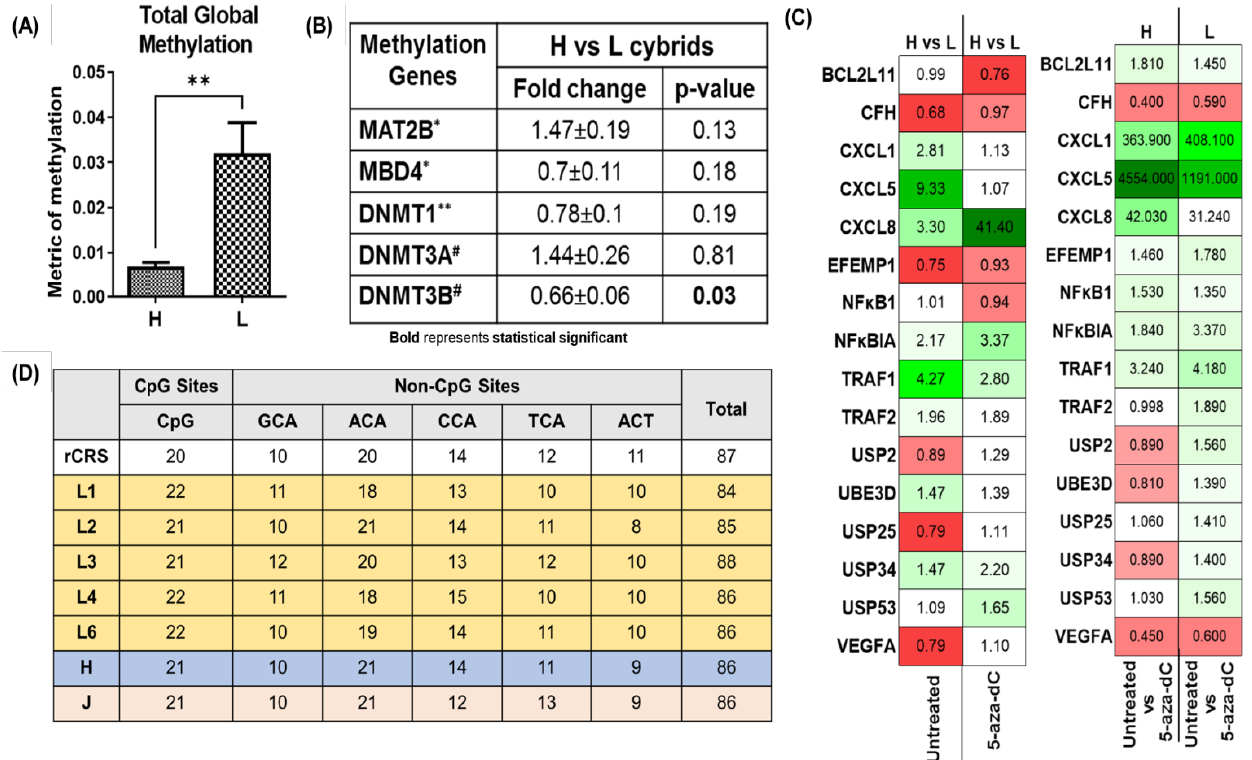
Figure 3. Evaluating the status of methylation in cybrids including mitochondrial haplogroups of European (H) and African (L) ancestry . ( A ) African-L cybrids showed increased levels of total global methylation. H (n = 5) and L (n = 5) cybrids were grown under identical conditions and DNA was extracted. The methylation fraction of DNA was detected using capture and detection antibodies and measured in a microplate spectrophotometer using an ELISA-like reaction (absorbance 450 nm). The OD intensity measured using an absorbance plate reader was proportional to the amount of methylated DNA (5-mC%). The L cybrids had a higher 5-mC% mean value compared to the H cybrids ( p = 0.005). To produce biological duplicates, samples were run in duplicate, and the experiment was repeated twice. ( B ) Expression levels of methylation genes in H cybrids versus L cybrids. Fold-change values greater than 1 indicate upregulation of the gene and those less than 1 indicate down-regulation of the gene compared to H cybrids. H cybrids are assigned a value of 1. * n = 5 different H cybrids and n = 5 different L cybrids, with three values for each sample, ** n = 5 different H cybrids and n = 5 different L cybrids, with three values for each sample, # n = 5 different H cybrids and n = 5 different L cybrids, with three values for each sample. ( C ) Heatmap representation of the differential expression of BCL2L11 , CFH , CXCL1 , CXCL5 , CXCL8 , EFEMP1 , NF κ B1 , NF κ BIA , TRAF1 , TRAF2 , USP2 , UBE3D , USP25 , USP34 , USP53 , and VEGFA genes before and after treatment with 5-aza-dC in H and L cybrids. ( D ) Potential methylation sites in the MT-Dloop (16411-460) for H and L cybrids compared to revised Cambridge Standard (rCRS). H and J represent cybrids created from 5 different individuals